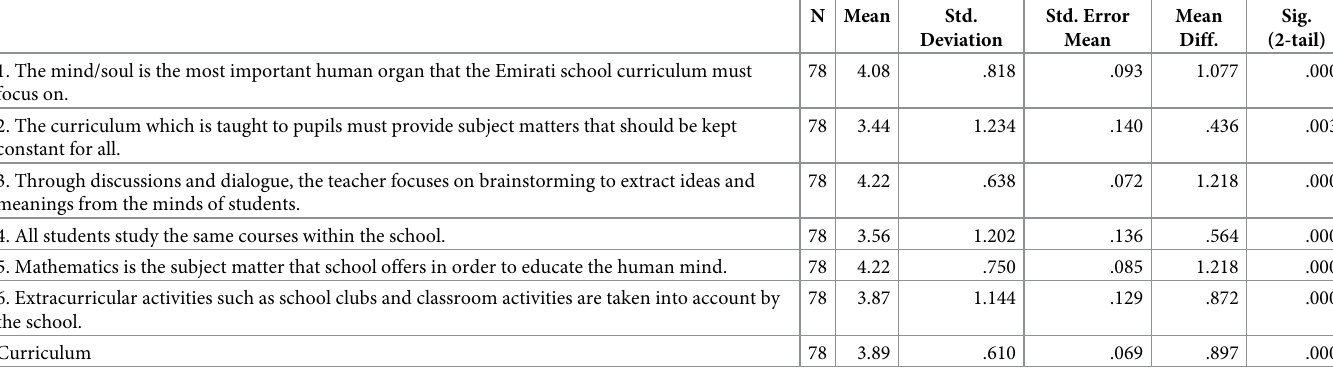
Table 4. One-sample statistics (curriculum and related items, test value = 3).